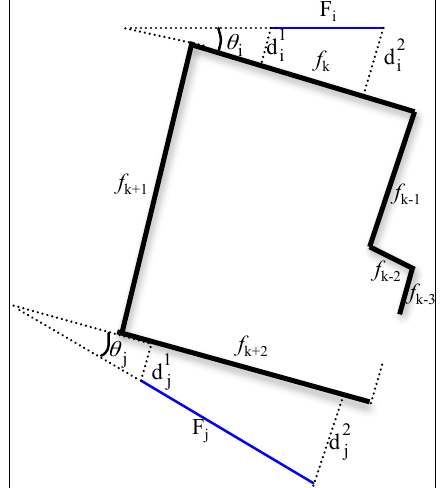
Figure 1. Geometric elements for defining the relative length, proximity, and orientation energy